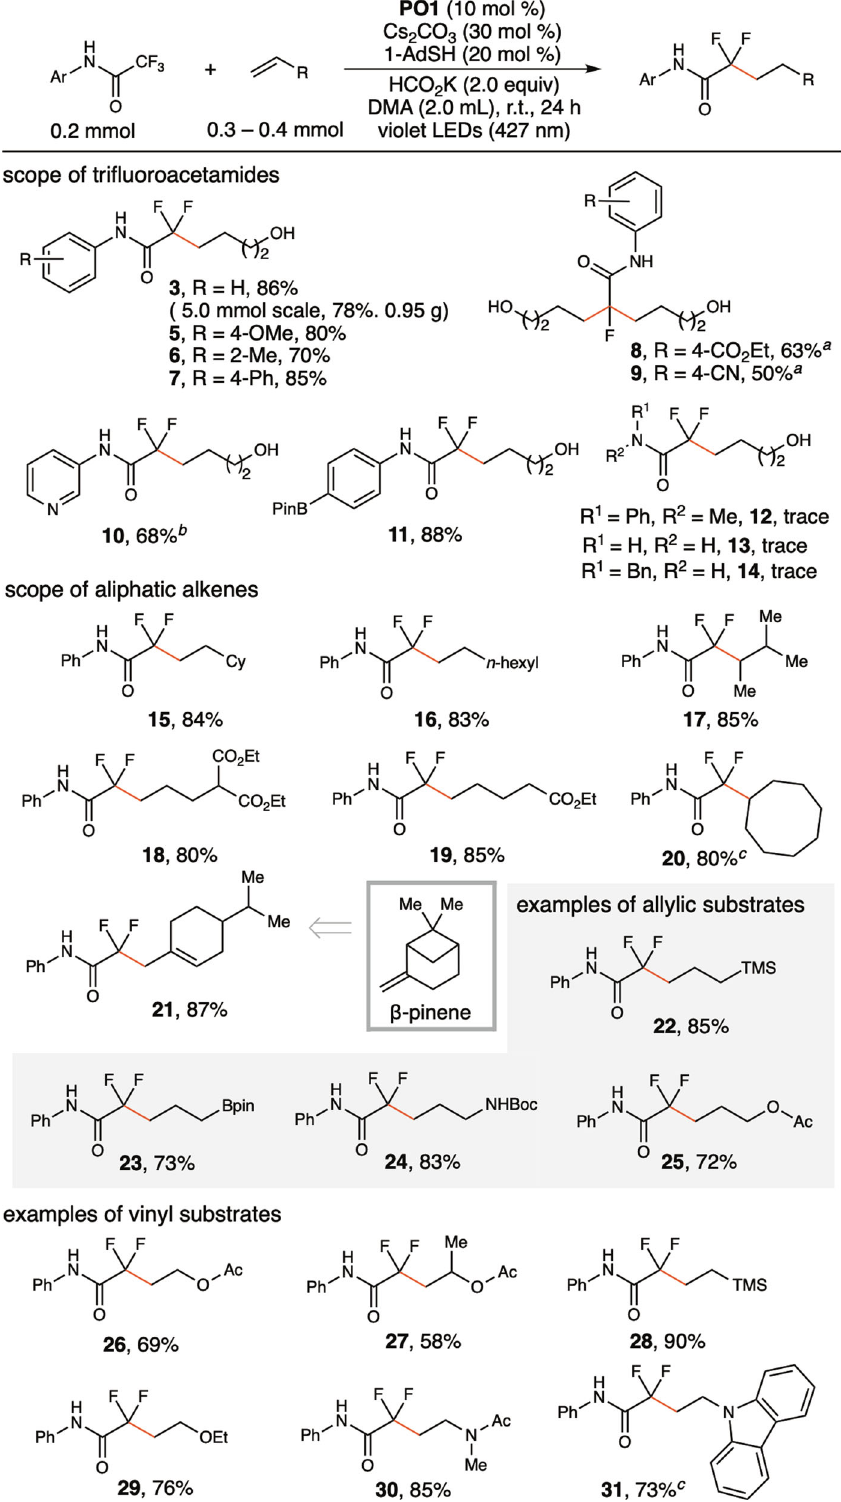
Fig. 3 Scope of de fl uoroalkylation of tri fl uoroacetamides. Yields of isolated products. a alkene (0.5 mmol), HCO 2 K (0.6 mmol). b PO3 (10 mol %) used instead of PO1 . c alkene (0.4